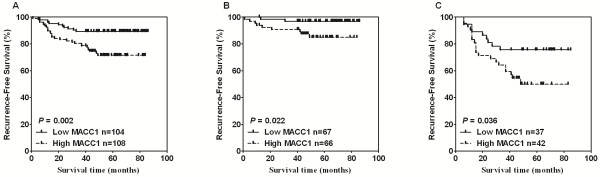
MACC1 expression in breast tumors is associated with reduced recurrence-free survival. A. Kaplan-Meier analysis of the probability of cumulative recurrence-free survival in breast cancer cases. B and C. recurrence-free survival analysis of MACC1 in high- and low-expression groups in LN- (B) and LN+ (C) subgroups.